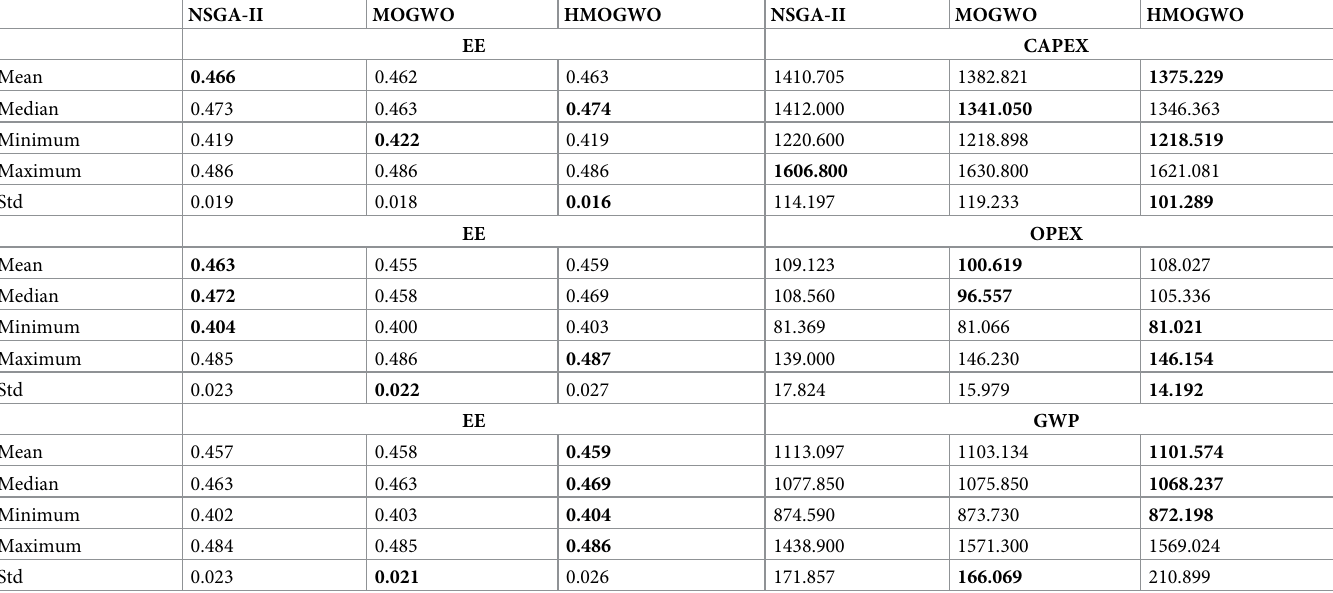
Table 11. Statistical analysis and comparison of the optimum results obtained by three algorithms.